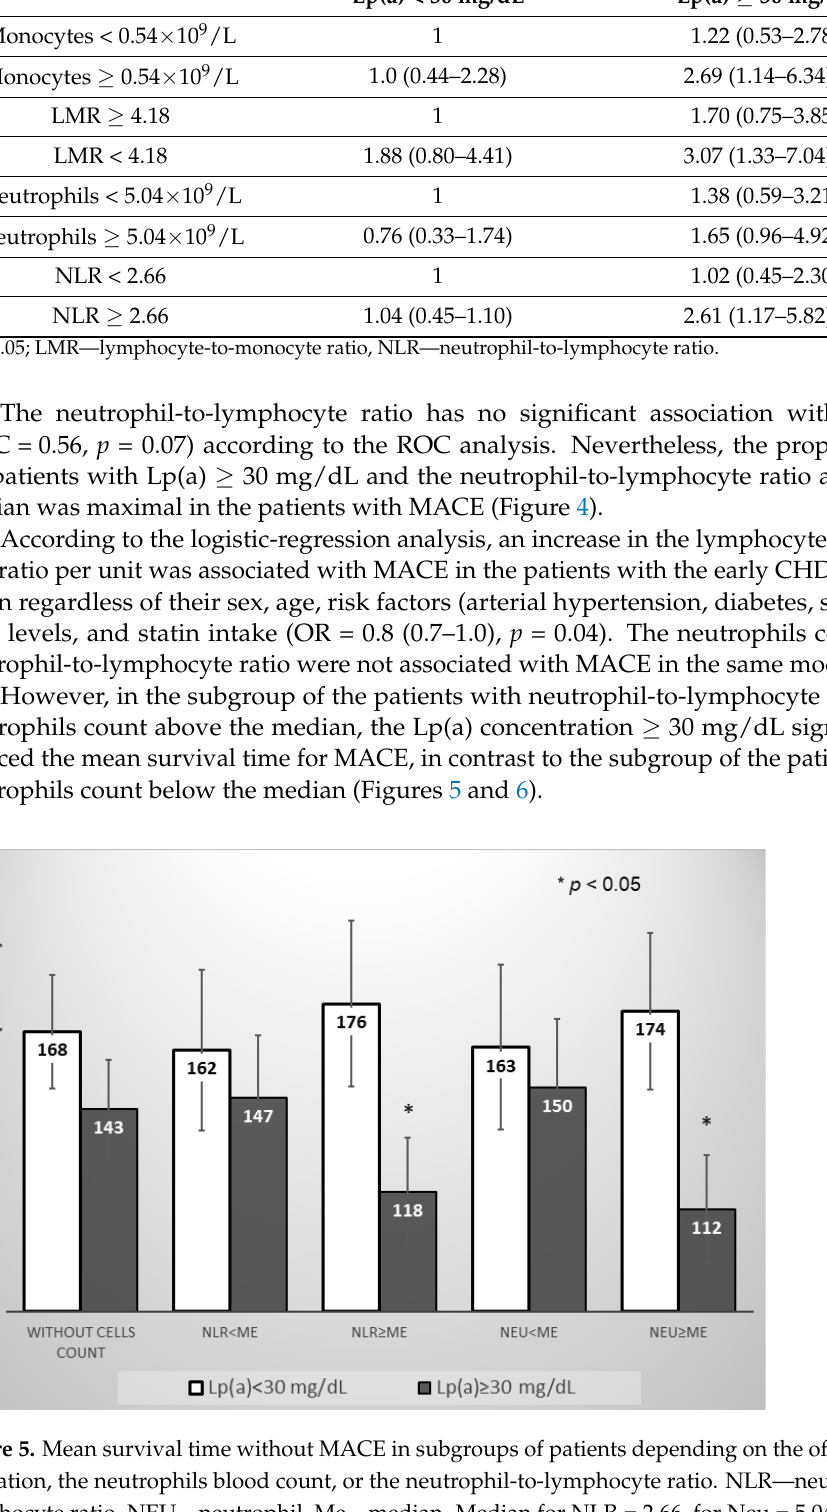
Table 3. MACE odds ratio in patients depending on Lp(a) concentration and blood immune cell distribution according to the median.